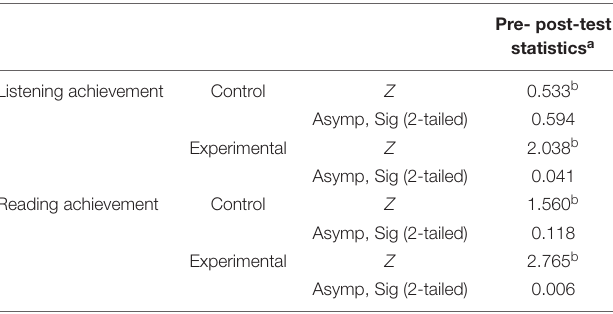
TABLE 6 | Listening and reading comprehension tests Wilcoxon signed ranks test results.